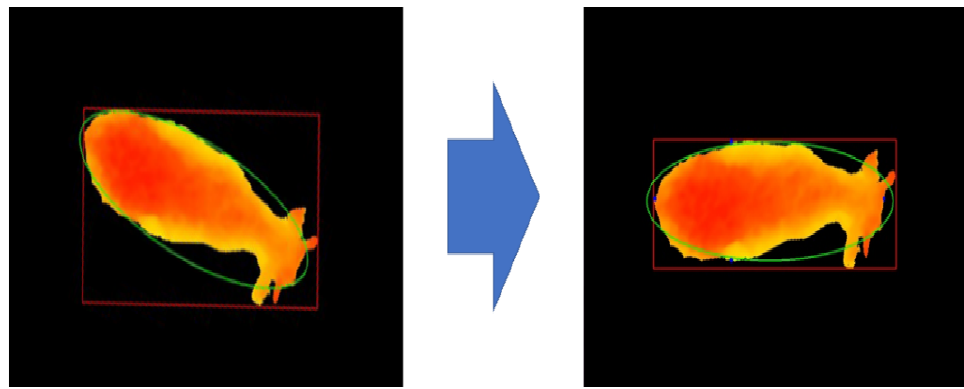
Figure 7. Correcting the posture of Korean cattle using ellipse fitting.